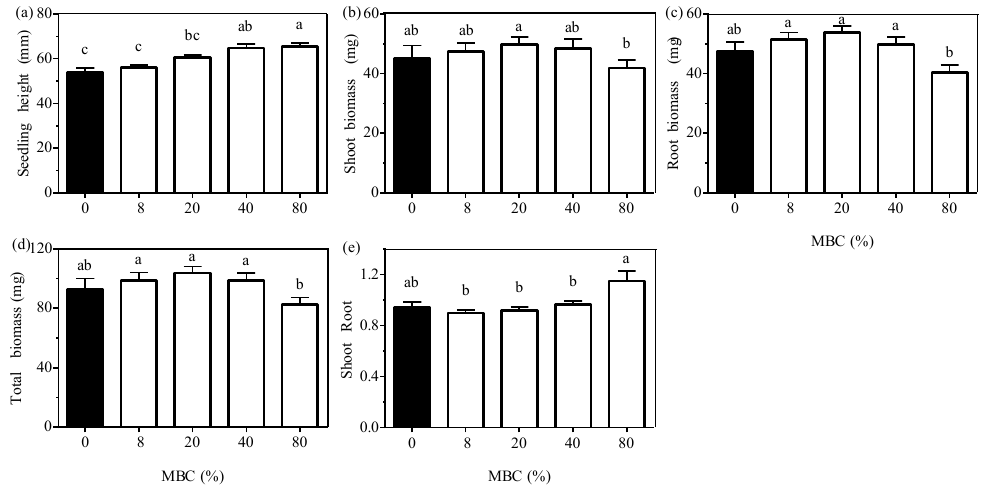
Figure 2. Response of Pinus sylvestris seedlings grown in pots containing different moss species of different moss biomass class (MBC), including a moss-free control, averaged across precipitation regimes and all moss species; bars show means + SE; within each subpanel, different letters above bars indicate significant pairwise differences at p <